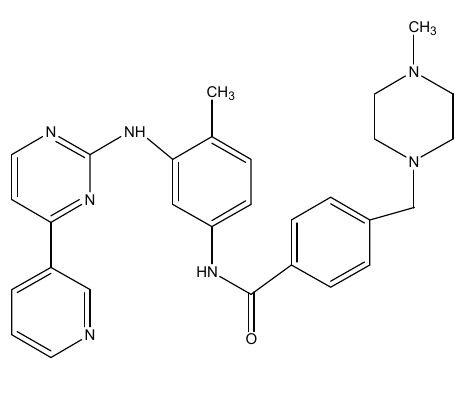
Figure 3. Structure of